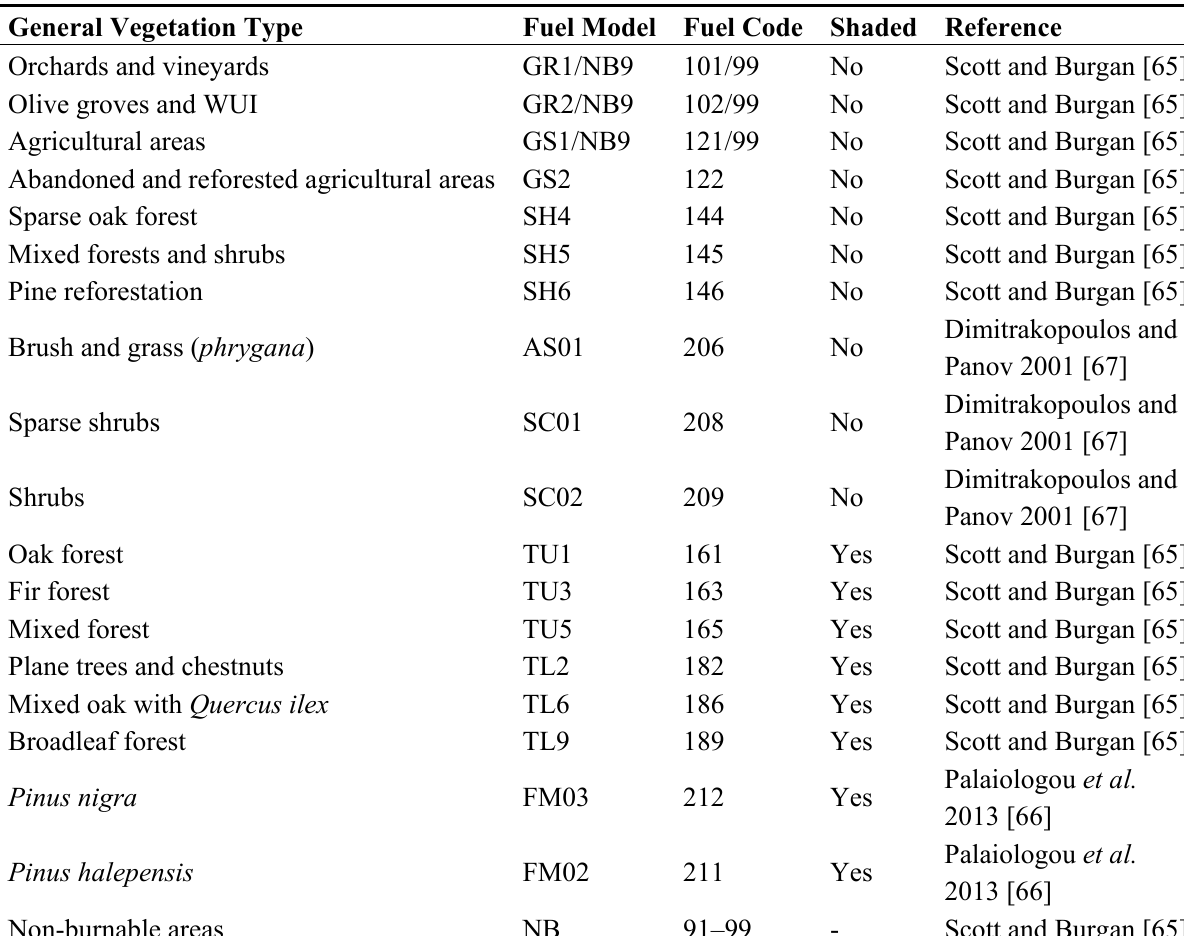
Table 2. Land use/land cover types, fuel models with the relevant codes and shading